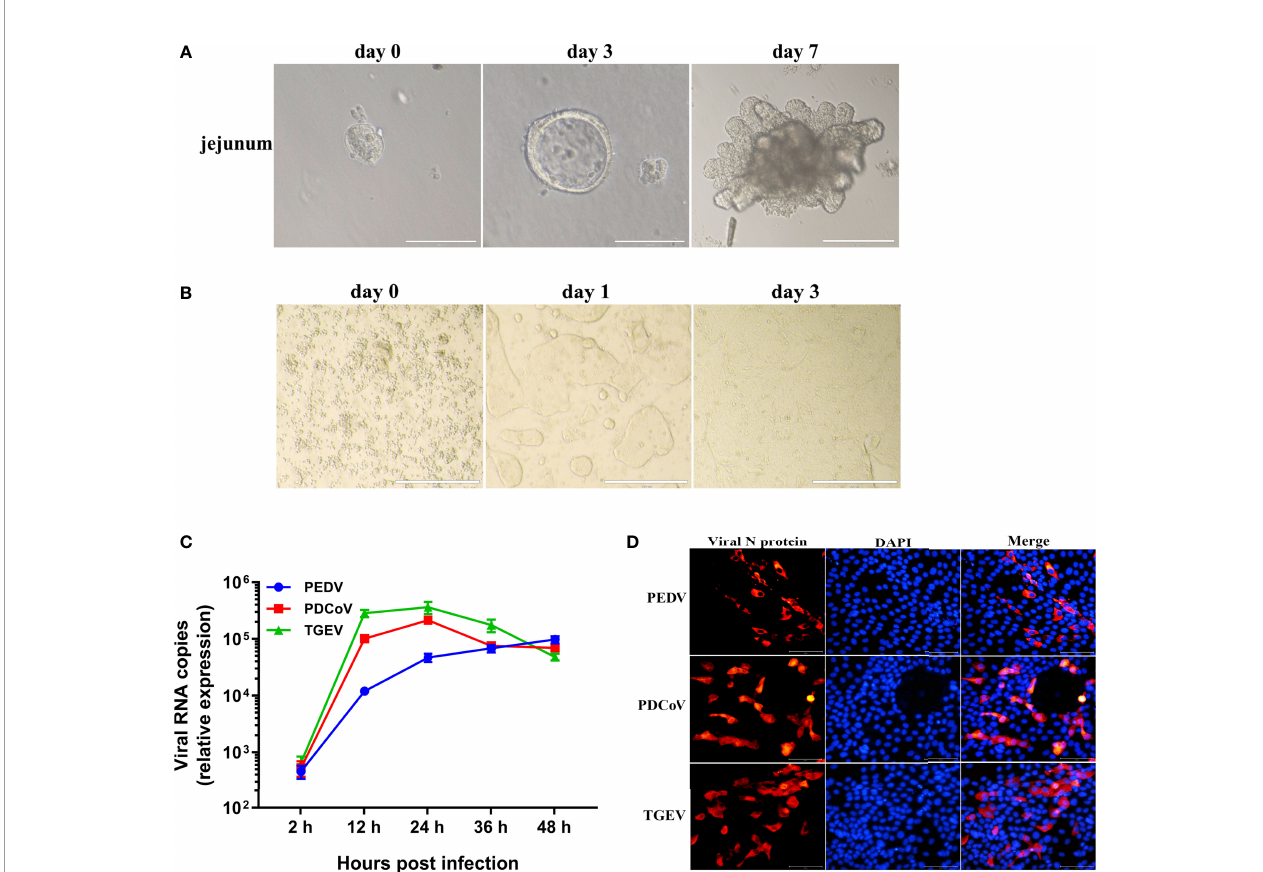
FIGURE 1 | Porcine enteroids are susceptible to PEDV, TGEV, and PDCoV infection. (A) Representative images of the proliferation and differentiation of porcine jejunal enteroids derived from crypt stem cells of jejunum. The isolated intestinal crypts cultured in proliferation medium mixed with Matrigel gradually formed 3D budding organ-like structures on day 7. Bar = 100 m m (day 0, 3) or 200 m m (day 7). (B) Representative images of 2D jejunal enteroid monolayers generated from differentiated 3D enteroids. After culturing for 7 days, 3D jejunal enteroids were dissociated into single cells and seeded onto 96-well plates precoated with Matrigel to differentiate for 3 days. (C) The kinetic curves of SECoVs replication in jejunal enteroids. Jejunal enteroid monolayers were respectively infected with PEDV (MOI = 5), TGEV (MOI = 1), or PDCoV (MOI = 2). The kinetics of SECoVs replication at the indicated time points post infection was determined by RT-qPCR. Each data bar represents the means ± SEMs (n = 3). (D) Examination of SECoVs infection in jejunal enteroids by IFA. Jejunal enteroid monolayers were respectively infected with PEDV (MOI = 5), TGEV (MOI = 1), or PDCoV (MOI = 2) for 24 h, and then were harvested for staining the N protein of SECoVs using the corresponding mouse anti- N monoclonal antibodies (red). DAPI-stained nuclei were shown in blue. Bar = 100 m